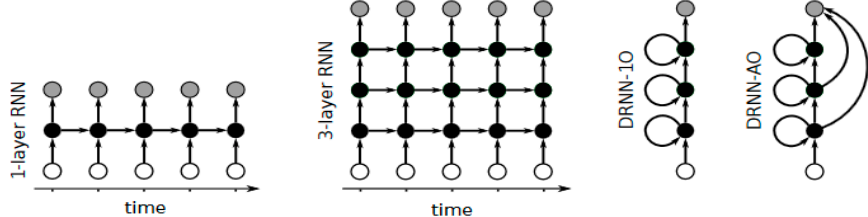
Figure 7. Different Recurrent Neural Networks architectures, the white circles represent the input layers, the black circles the hidden layers, and the grey circles the output layers [65].